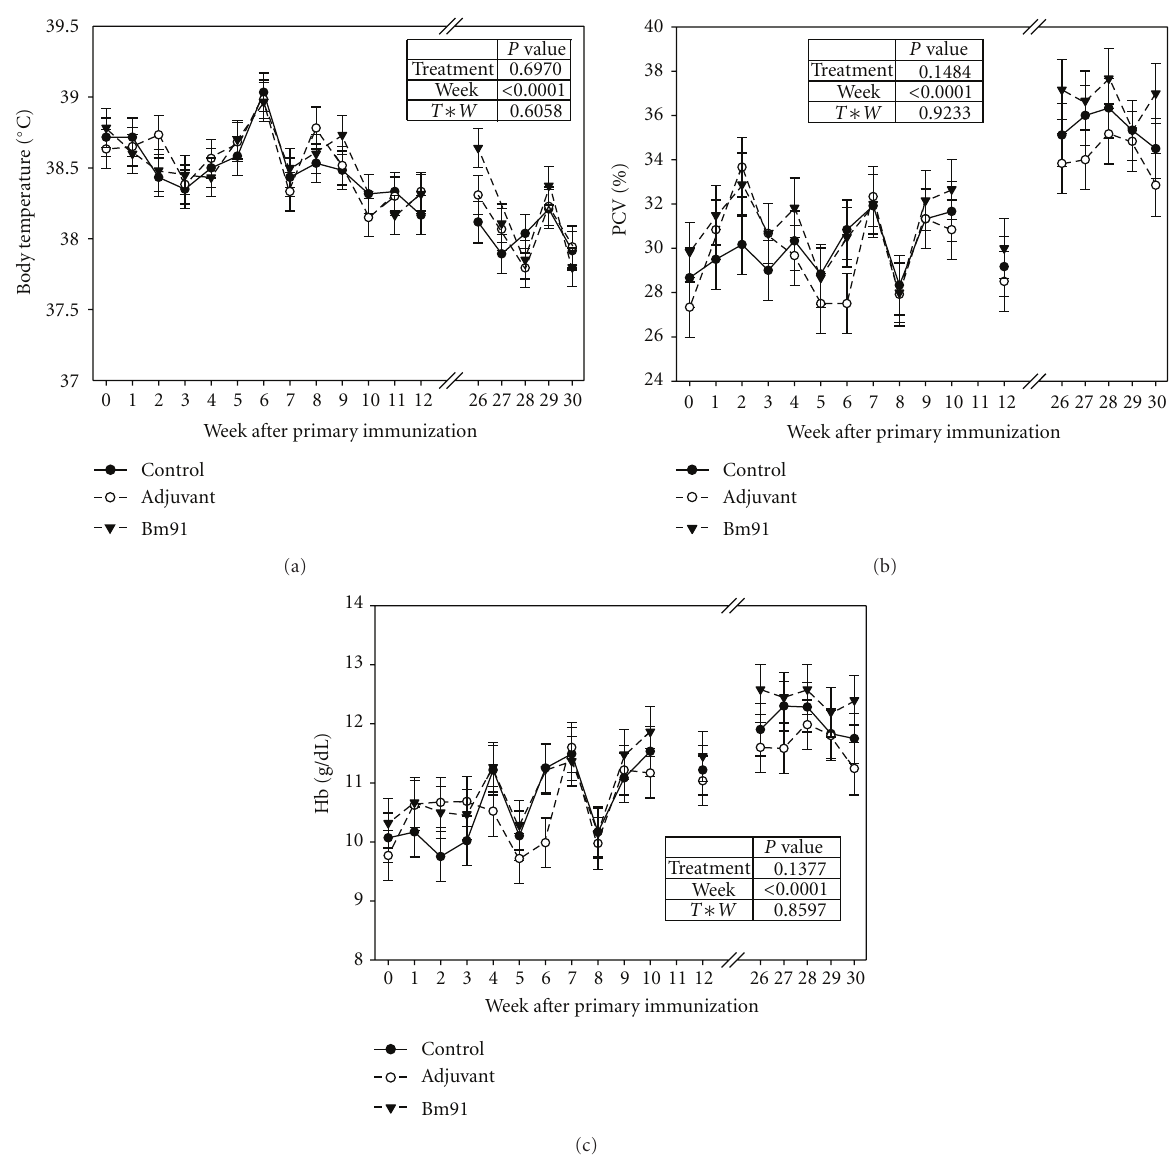
Figure 3: Body temperature (a), PCV (b), and Hb (c) of Bos indicus cattle immunized with the antigen Bm91 and injected with saline (control), and adjuvant, respectively (LSM ± S.E.; N = 6).